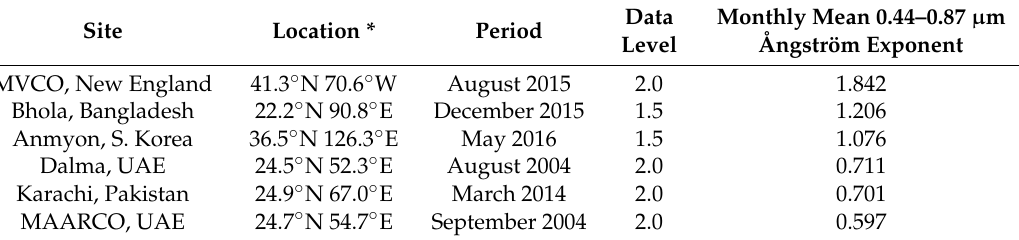
Table 1. Information of AERONET sites used for